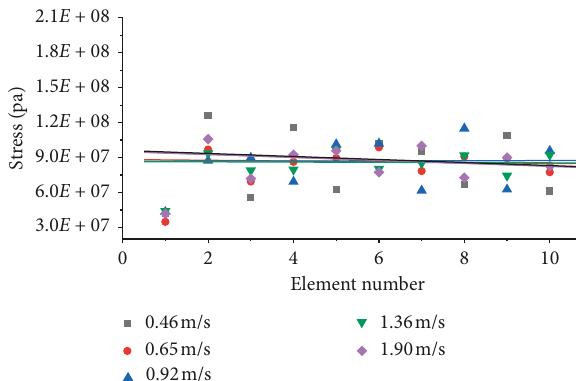
Figure 20: The average stress of representative elements under different cutting speeds ( α